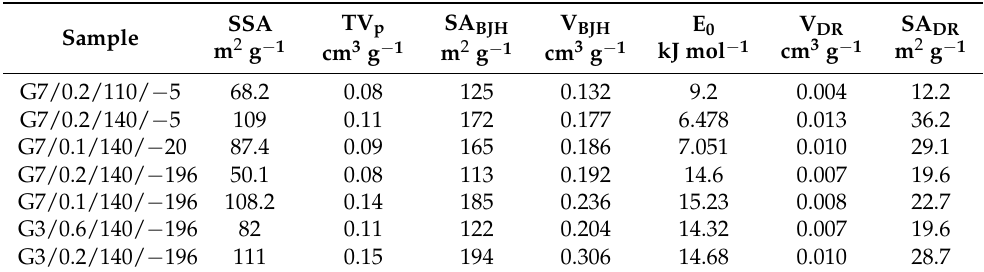
Table 2. Nitrogen adsorption results as a function of synthesis conditions. (sample notation: